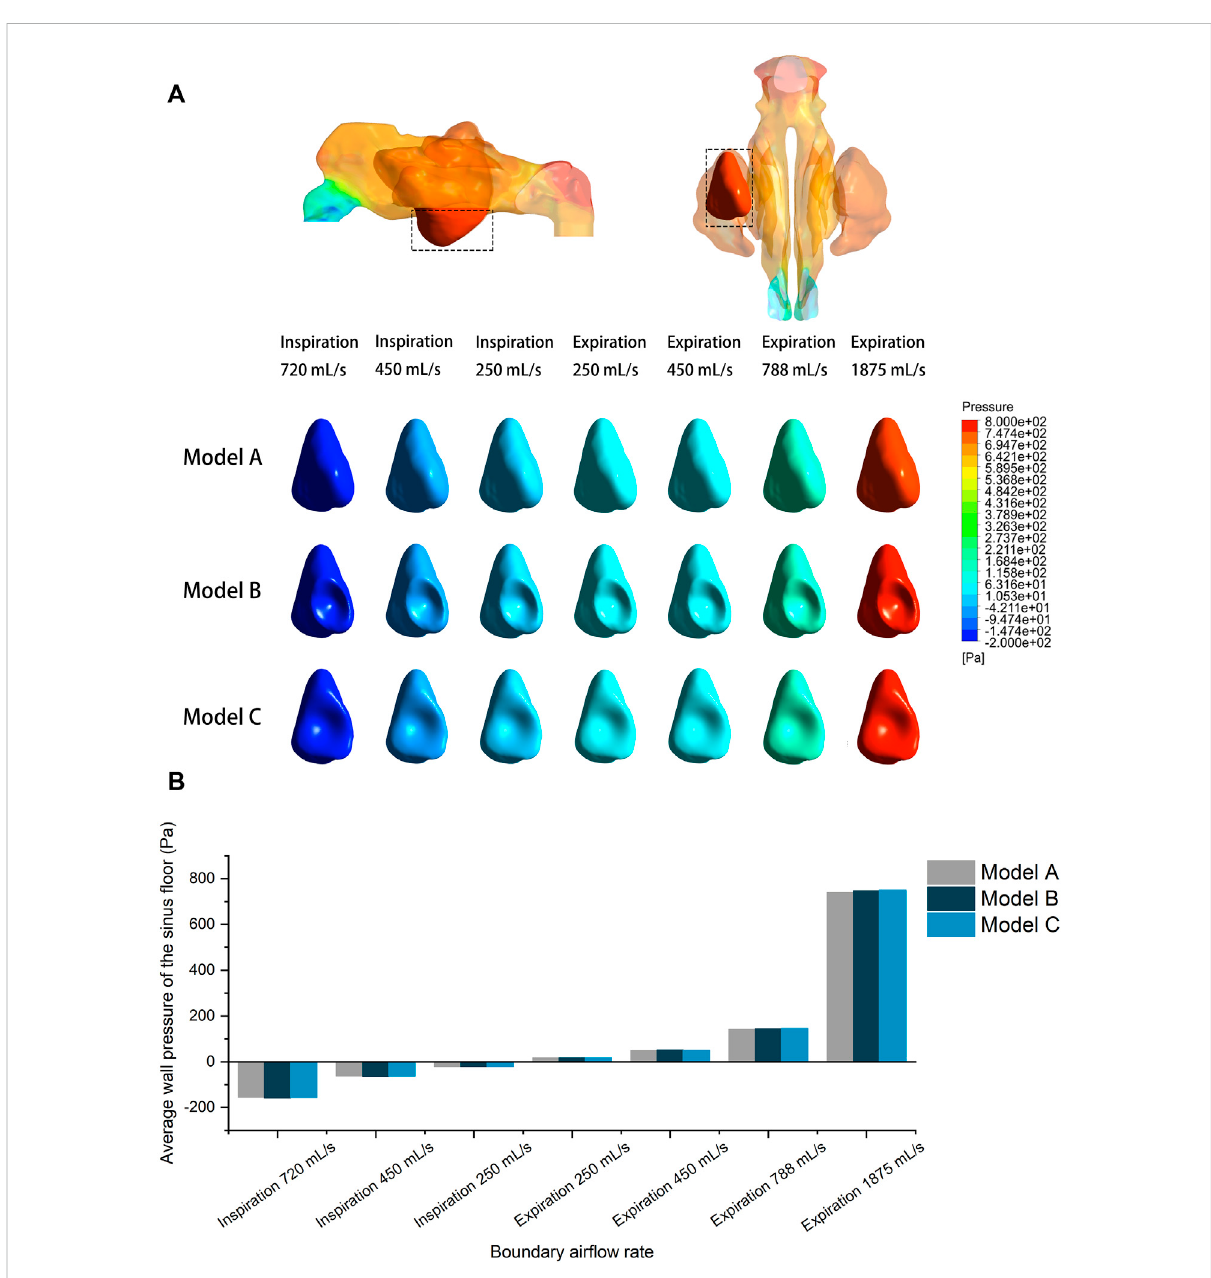
FIGURE 6 (A) Wall pressurecontourofthepre-andpost-operativesinus fl oorunderdifferentinlet fl owrates. (B) Quantitativecomparisonofaverage wall pressure on the pre- and post-operative sinus fl oor under different fl ow